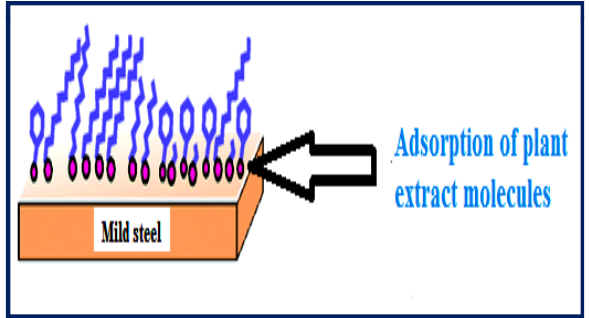
Fig. 1. Schematic representation of adsorption of plant extracts species on the mild steel surface